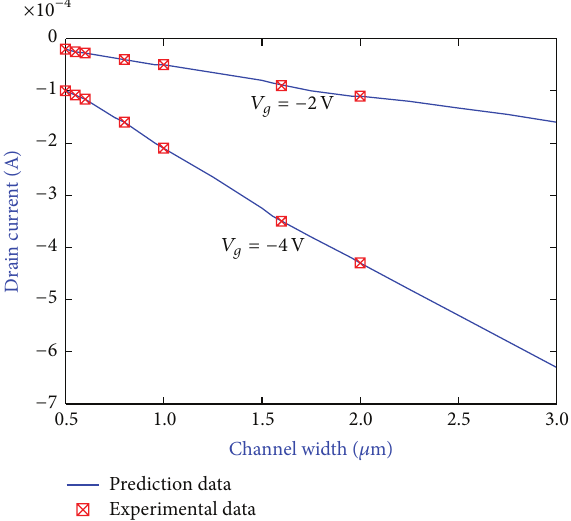
Figure 13: Comparison of 𝐼 𝑑 measured results and prediction data of the group 2A samples (as 𝑉 𝑔 = −2 , − 4V, 𝑉 𝑑 = −3 V). 𝑊 and 𝑉 𝑉 − 3 V for 𝑔 as the drain voltage ( 𝑑 ) set to be